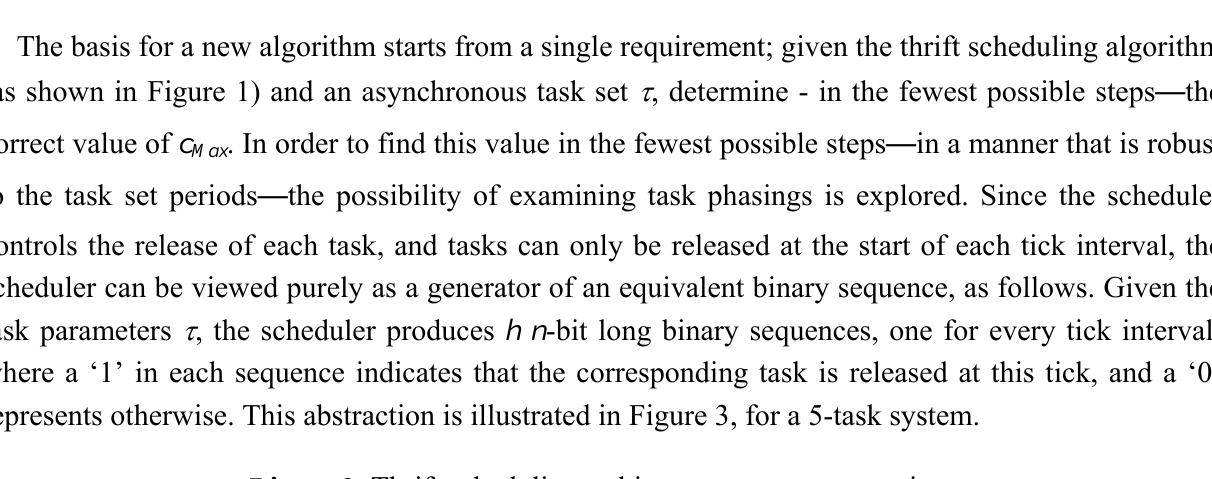
Figure 3. Thrift scheduling as binary sequence